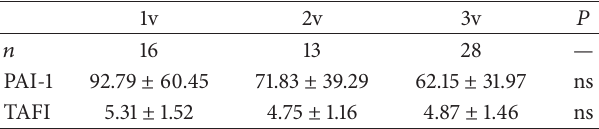
Table 4: Plasma fibrinolysis markers considering number of affected